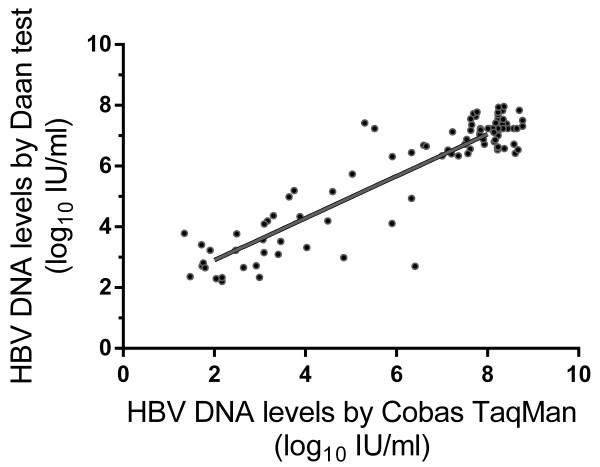
The correlation of 2 methods in a total of the hundred positive of the 134 samples. The Spearman’s correlation coefficient in HBV DNA level between the 2 methods was rp = 0.79 (P < 0.001).